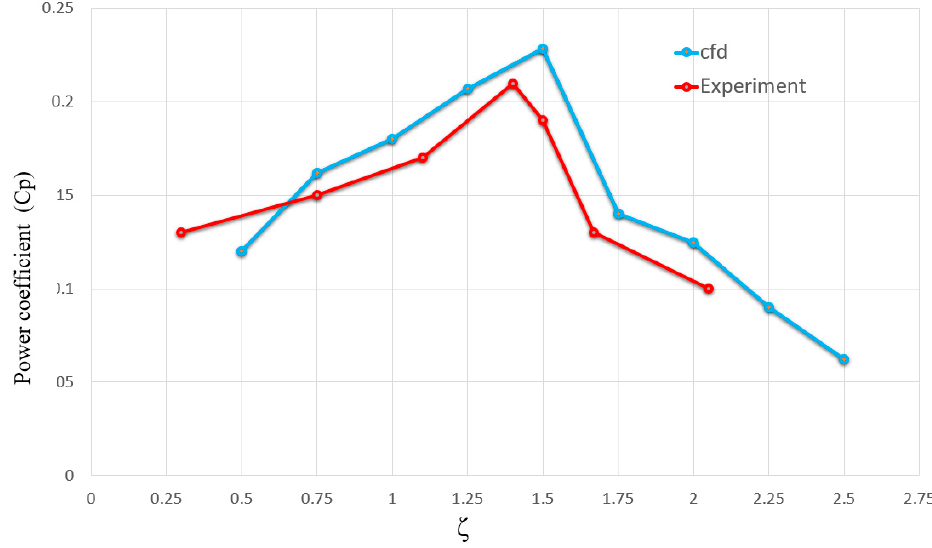
Figure 8. Power coefficient ( C P ) vs. tip speed ratio ( ζ ) for validation of the computational fluid dynamics (CFD) model with the experimental work.